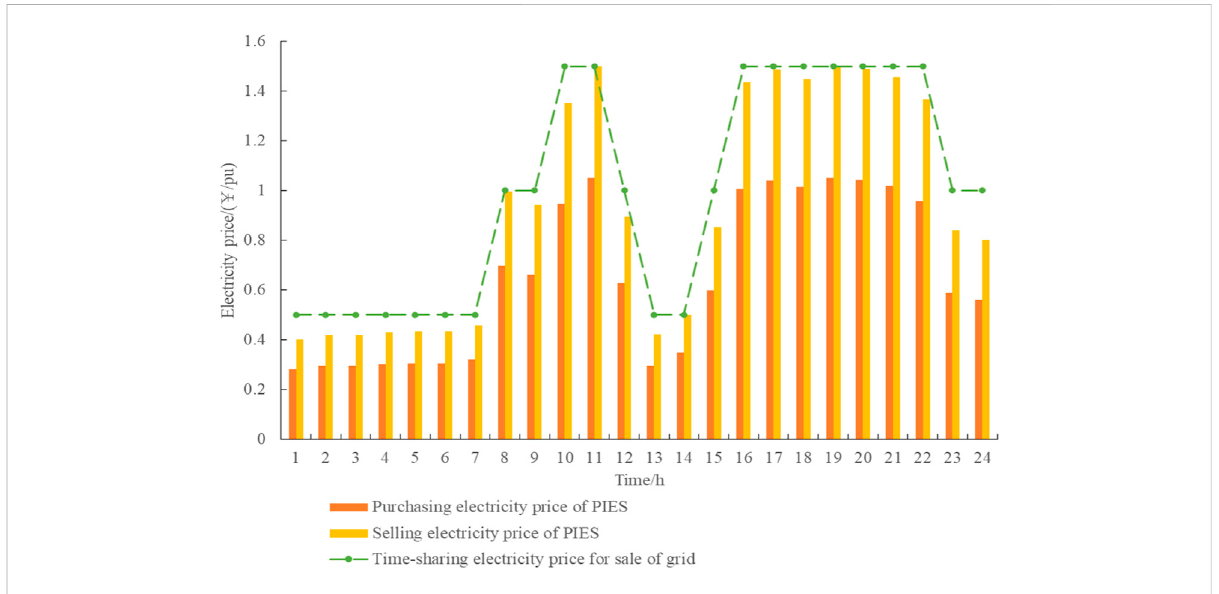
FIGURE 10 PIES purchases and sells electricity from the power